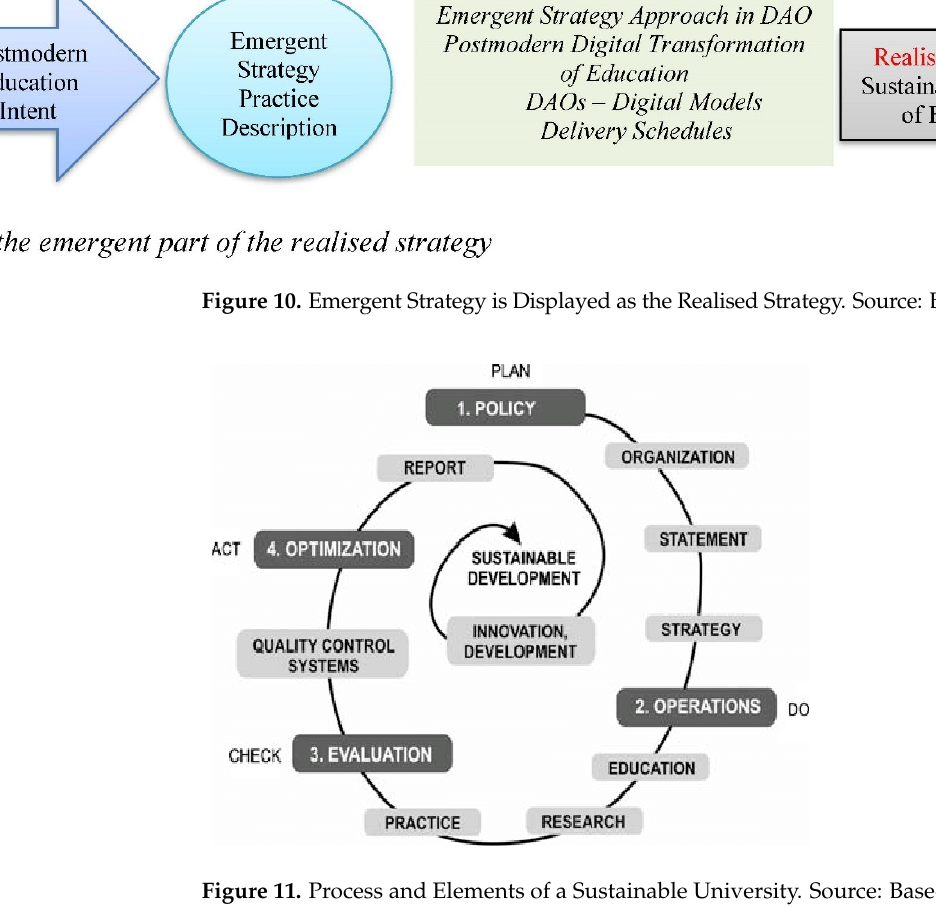
Figure 11. Process and Elements of a Sustainable University. Source: Based on Glavi č and Lukman (2007). Source: www.google.com (accessed on 1 December 2022) based on Glavi č and Lukman (2007)